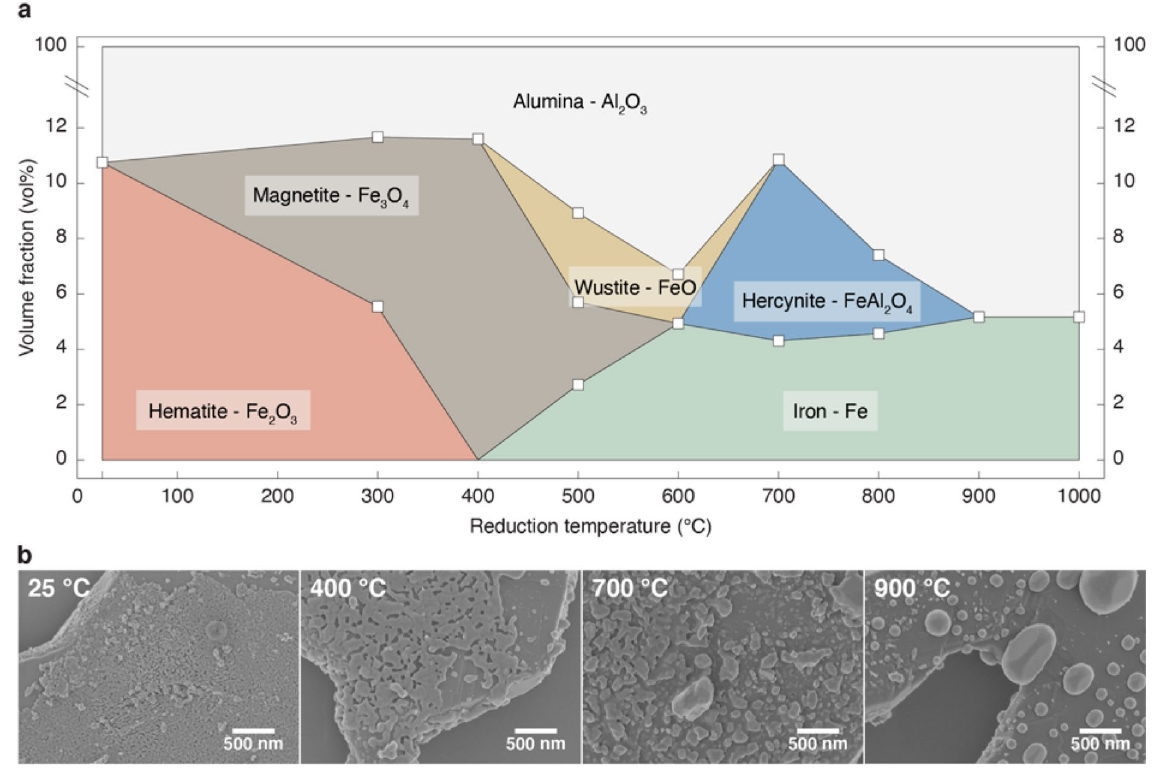
Figure 3. Crystallography and morphology of the platelet coating after heat treatment at distinct temperatures under reducing atmosphere in a small-batch process. ( a ) Volume fraction of each crystalline phase present in coated platelets subjected to different reduction temperatures for 8 h. The initial coated platelets consist of 89% Al 2 O 3 and 11% Fe 2 O 3 . The lines between experimental data points are guides to the eye. ( b ) SEM images of the platelet coating at selected temperatures, highlighting the morphological changes associated with the phase transformations of the initial hematite particles. Magnification: 85 k